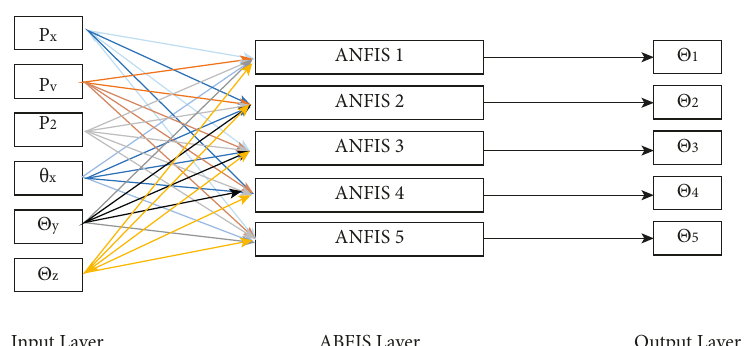
Figure 6: MANFIS structure.